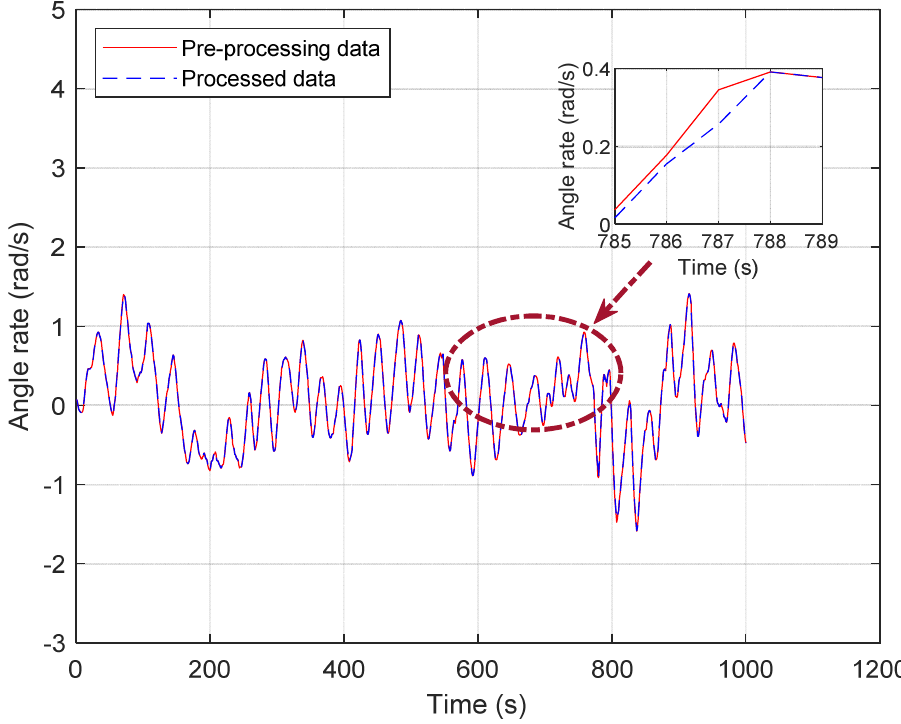
Figure 2. Processing of sampled data (gyroscope).